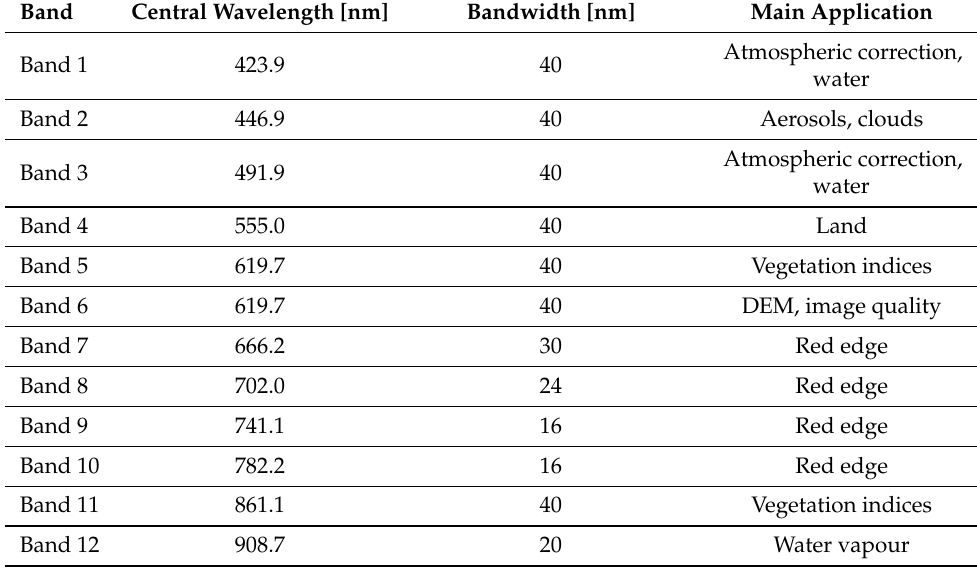
Table 1. VEN µ S spectral bands and their primary applications. Source: